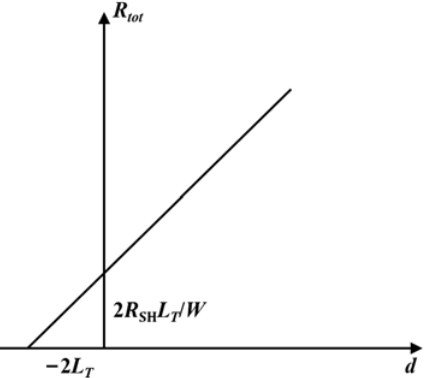
R SH / W , and the intercept is 2 R SH L T / W . The R SH and the L T can be obtained, and the specific contact resistance ρ c is calculated as ρ c = L T 2 R SH .